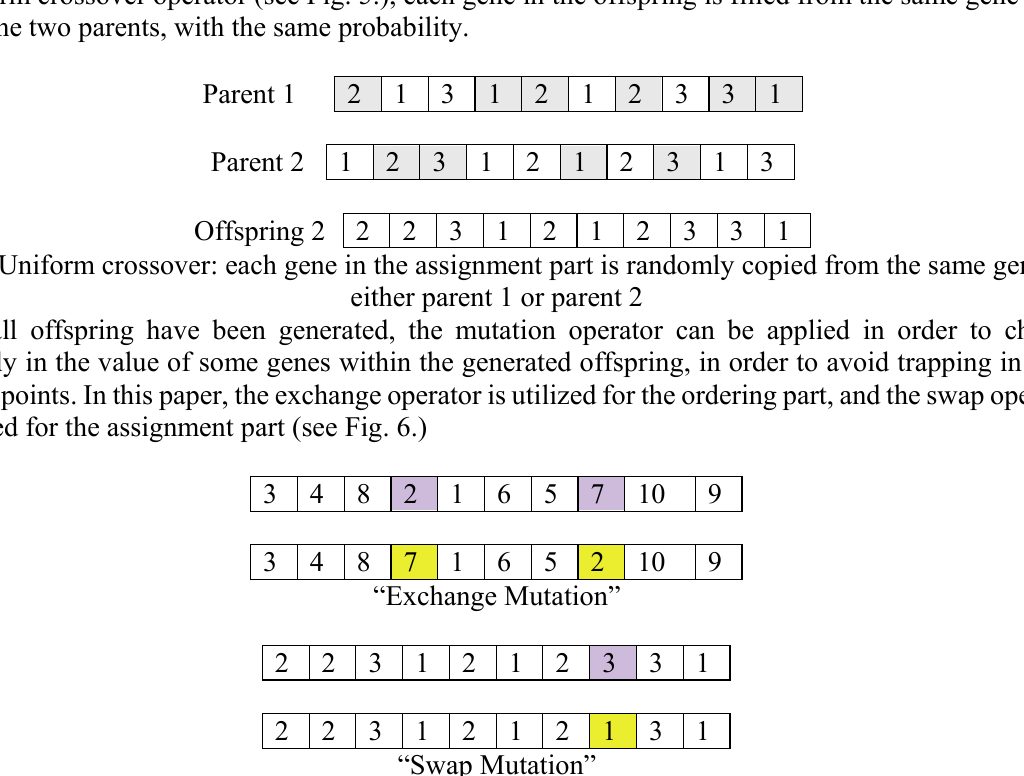
Fig. 6. Mutation Operators to change randomly in the value of some genes within the generated offspring for the ordering and assignment